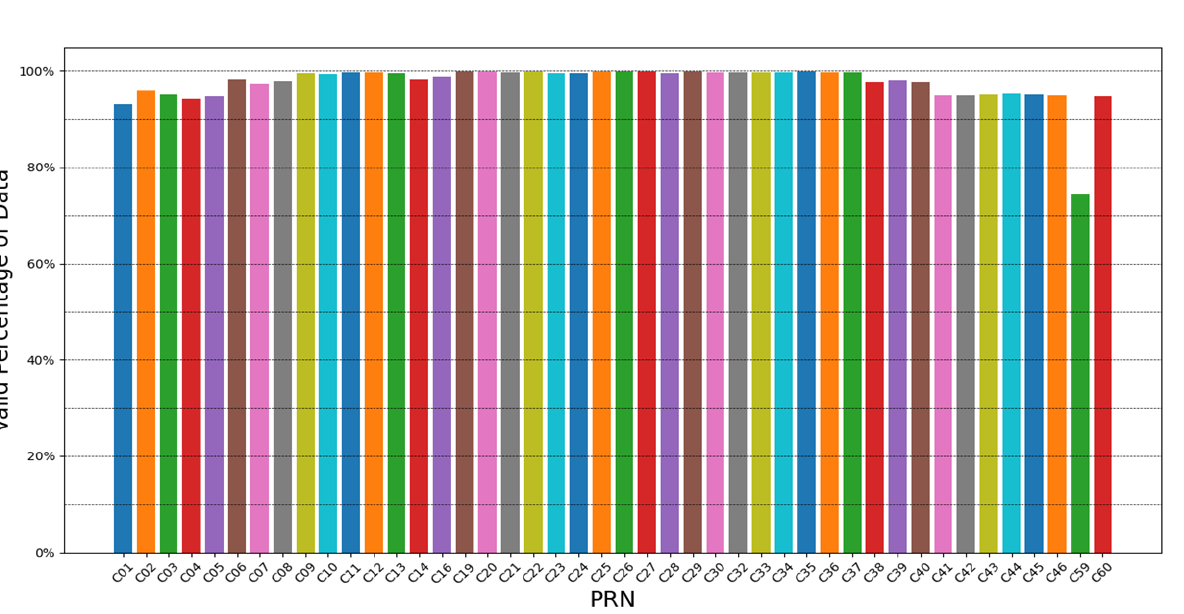
Figure 1. The Data Availability of BDS Satellites.